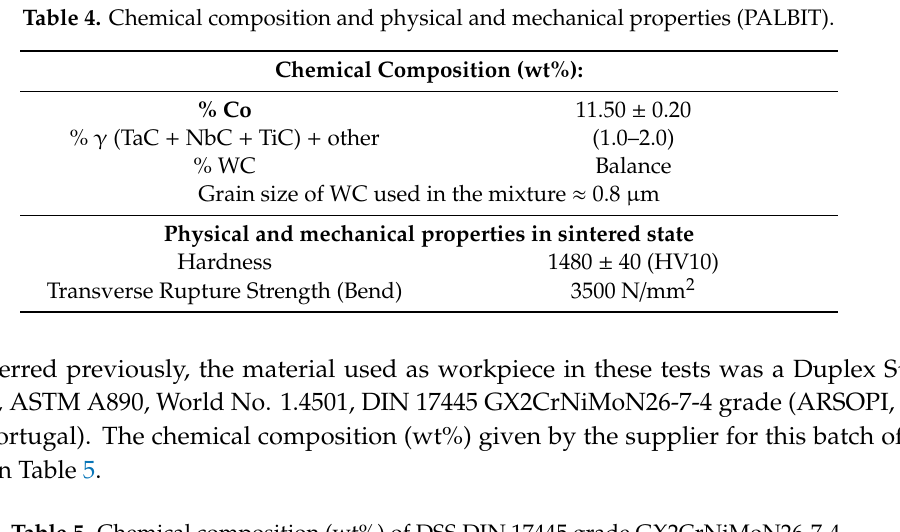
Table 5. Chemical composition (wt%) of DSS DIN 17445 grade